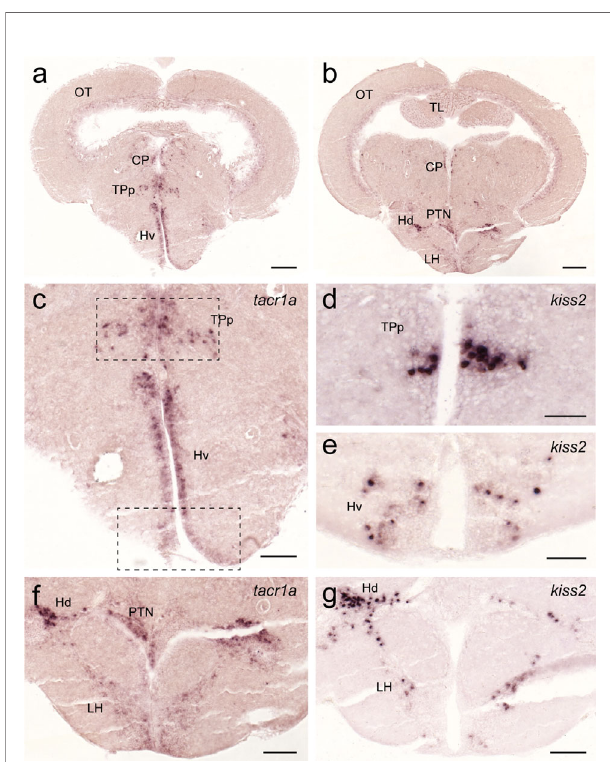
FIGURE 10 | Expression of tacr1a mRNA in the hypothalamic regions containing kiss2 cells. In the hypothalamic regions, tacr1a mRNA is expressed in several regions (A , C) including the ventral nucleus of the ventral telencephalic area and the periventricular nucleus of the posterior tuberculum (dotted box), where kiss2 neurons are present (D , E) . In addition, tacr1a expression was also seen in the lateral hypothalamic nucleus towards the dorsal zone of the periventricular hypothalamus (B , F) , where another group of kiss2 neurons is present (G) . Scale bars: (A , B) , 200 µm; (C, F, G) , 100 µm; (D , E) , 50 µm. See Glossary for